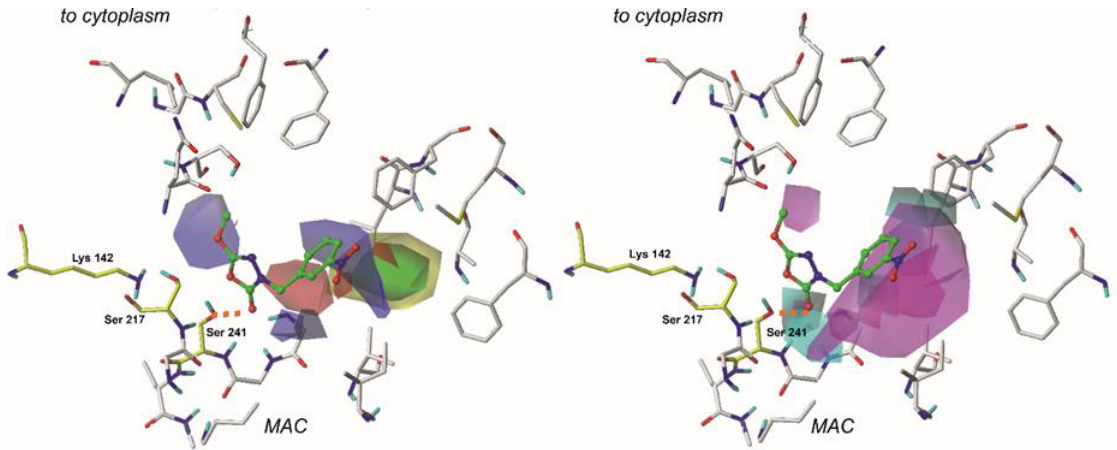
Figure 6. Comparative Molecular Similarity Indices Analysis (CoMSIA) steric, electrostatic (left), H-bond acceptor and H-bond donor (right) fields projected on the 3D-structure of fatty acid amide hydrolase in complex with the least active compound ( 31 ). Fields are drawn with 60/40, 70/30, 60/40, 60/40 proportions, respectively. Ligands are shown as sticks and balls with green carbon atoms. Protein is shown as wires with gray carbon atoms. Catalytic residues are presented as sticks and colored using yellow carbon atoms. A bond formed between a ligand and an enzyme is depicted as an orange dashed line. Non-polar hydrogens are omitted for clarity.